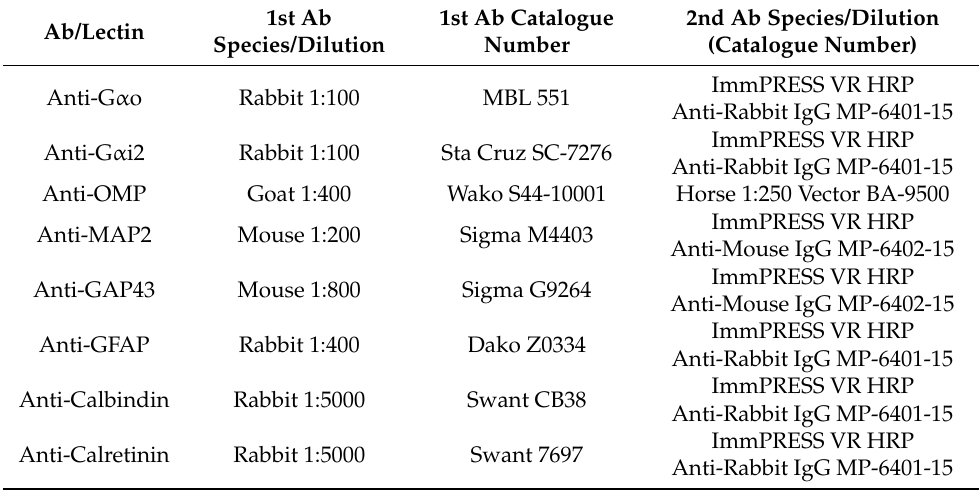
Table 1. Lectins and antibodies employed. Species of elaboration, manufacturer, dilutions, catalog number.